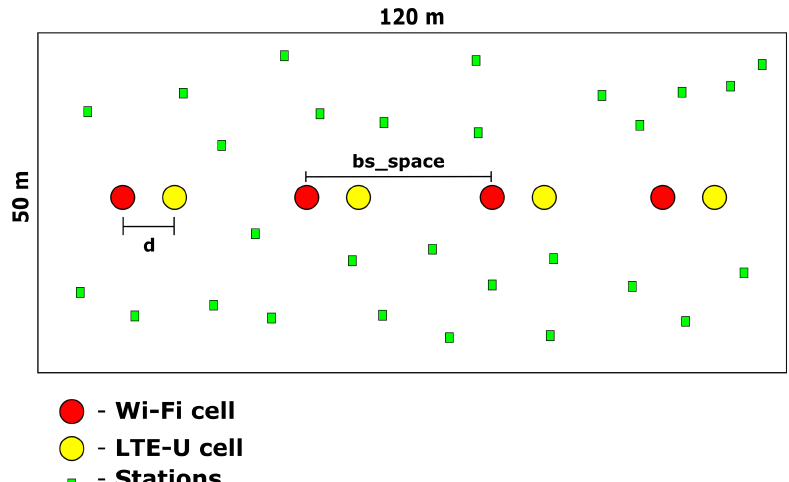
Figure 3. Evaluation indoor scenario proposed by the 3rd generation partnership project